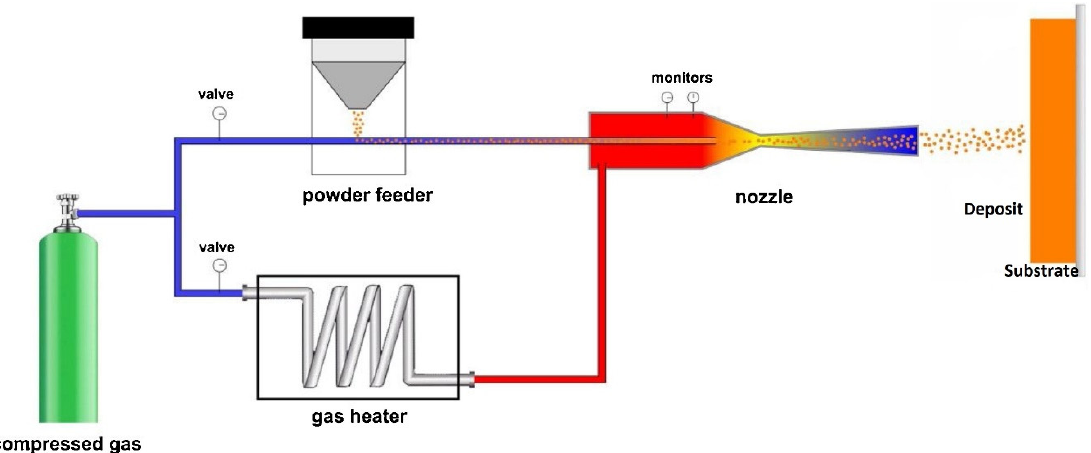
Figure 11. A schematic of the cold spray process. Reprinted with permission from [139] Copyright 2019 Elsevier.